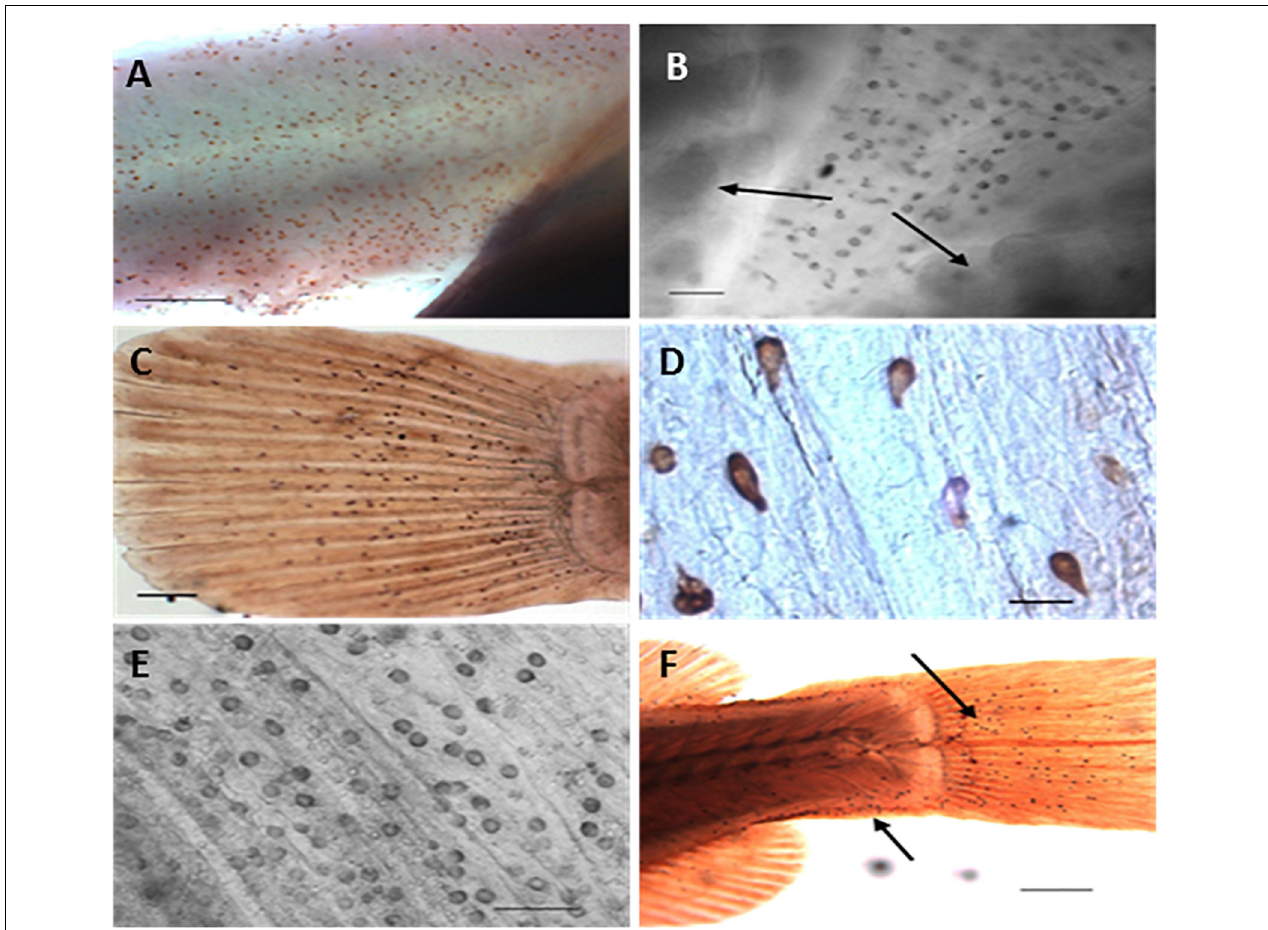
FIGURE 4 | Distribution of ionocytes as revealed by anti-Na + /K + -ATPase antibody during post-embryonic development of Nile tilapia ( Oreochromis niloticus ) using light microscopy. (A) Detail of anal region of freshwater adapted larvae at 3 days post hatch (dph showing clustered immunoreactive ionocytes (Bar = 200 µ m), (B) Ionocytes on ventral region of brackish water adapted larvae at 3 dph. Arrows indicates presence of gills underlying opercula (Bar = 30 µ m), (C) Caudal fin of freshwater adapted larvae at 3 dph showing immunoreactive ionocytes (Bar = 200 µ m) (LM), (D) Detail of immunoreactive ionocytes on caudal fin of brackish water adapted larvae at 3 dph (Bar = 20 µ m), (E) Inner opercular area of freshwater adapted larvae at 5 dph showing immunoreactive ionocytes (Bar = 50 µ m) (LM) and (F) Caudal extremity of brackish water adapted larvae at 7 dph. Arrows indicate location of clustered immunoreactive ionocytes (Bar = 300 µ m) [from Fridman et al.